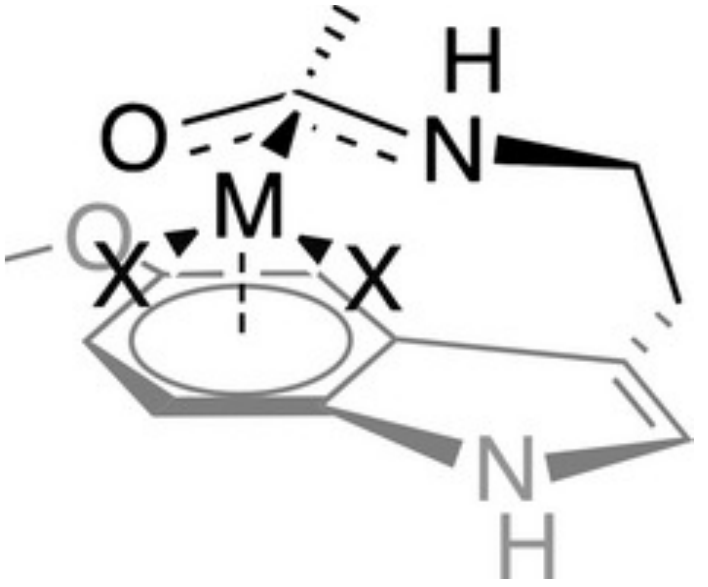
Figure 4. Hypothetical η 6-coordination of metals to melatonin through the π -electron density of the benzene-fused ring in a tetrahedral-like fashion. From Romero et al. [12], with permission.